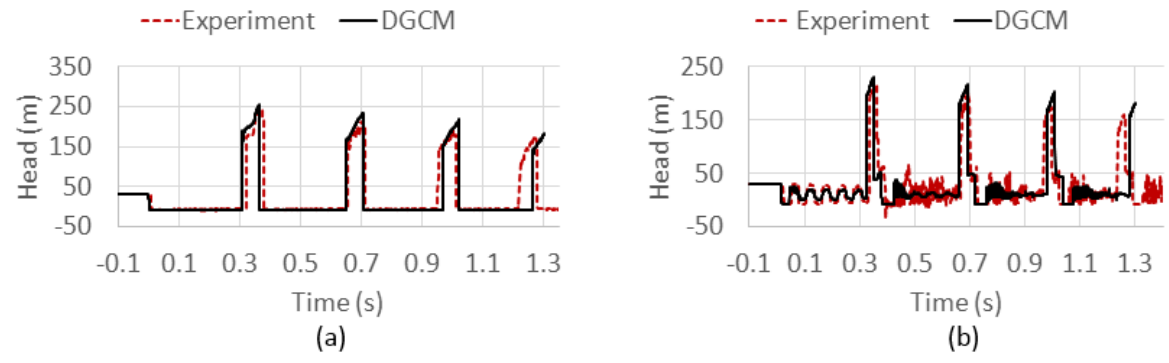
Figure 5. pressure time histories calculated by DGCM at; ( a ) valve; ( b ) pipe mid-point. Figure 5. Pressure time histories calculated by DGCM at; ( a ) valve; ( b ) pipe